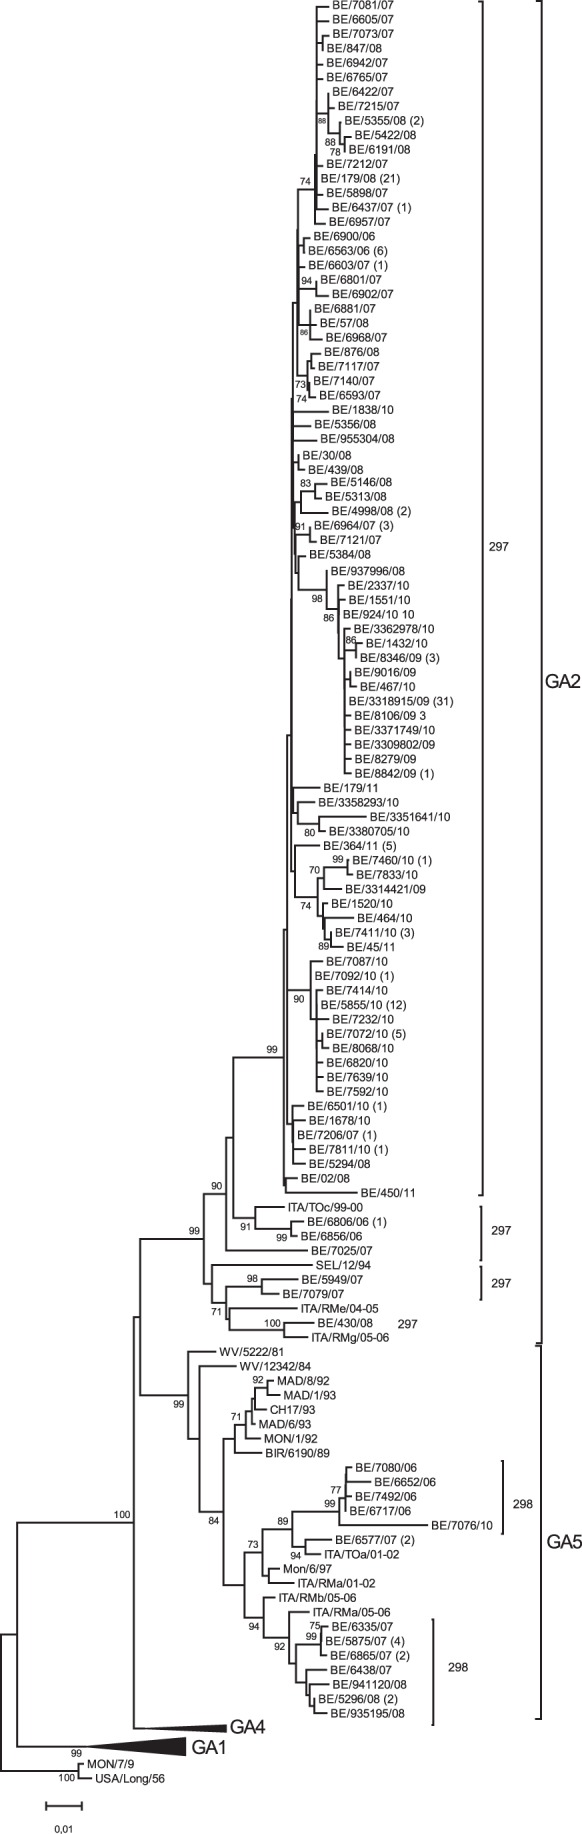
Phylogenetic tree of HRSV-A strains.The phylogenetic tree was constructed based on a 624-nucleotide fragment of the G protein, consisting of the two hypervariable regions. The nucleotide sequences of the Belgian strains isolated during 5 consecutive epidemic seasons (2006–2011) were compared with reference strains from Italy (ITA), Madrid (MAD), Montevideo (MON), West Virginia (WV) and Birmingham (BIR). The outgroup is represented by the Long strain. Bootstrap values are indicated at the internal nodes and are calculated for 1000 replicates by using the neighbour joining method. Only bootstrap values >70 are shown. The numbers between brackets are the number of strains identical to one shown in the tree. The amino acid lengths predicted for the G protein are indicated next to the Belgian isolates. For both the GA2 and GA5 genotypes, a strong temporal clustering of the strains per epidemic season is observed.